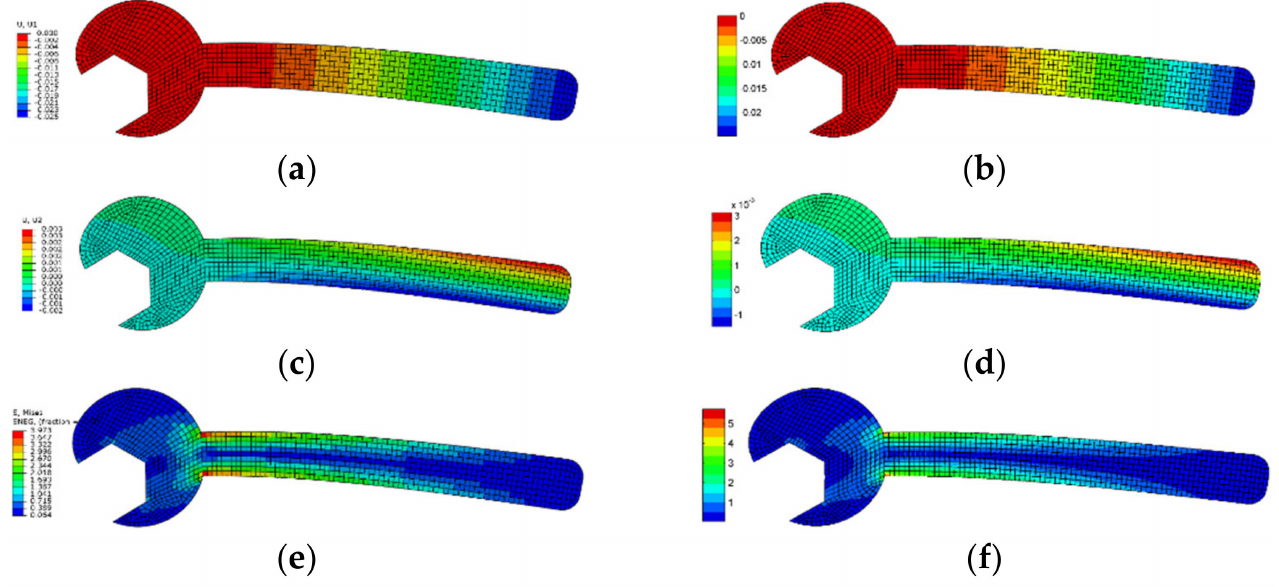
Figure 13. ( a ) x-displacement by Abaqus; ( b ) x-displacement by IGA; ( c ) y-displacement by Abaqus; ( d ) y-displacement by IGA; ( e ) Mises stress by Abaqus; ( f ) Mises stress by